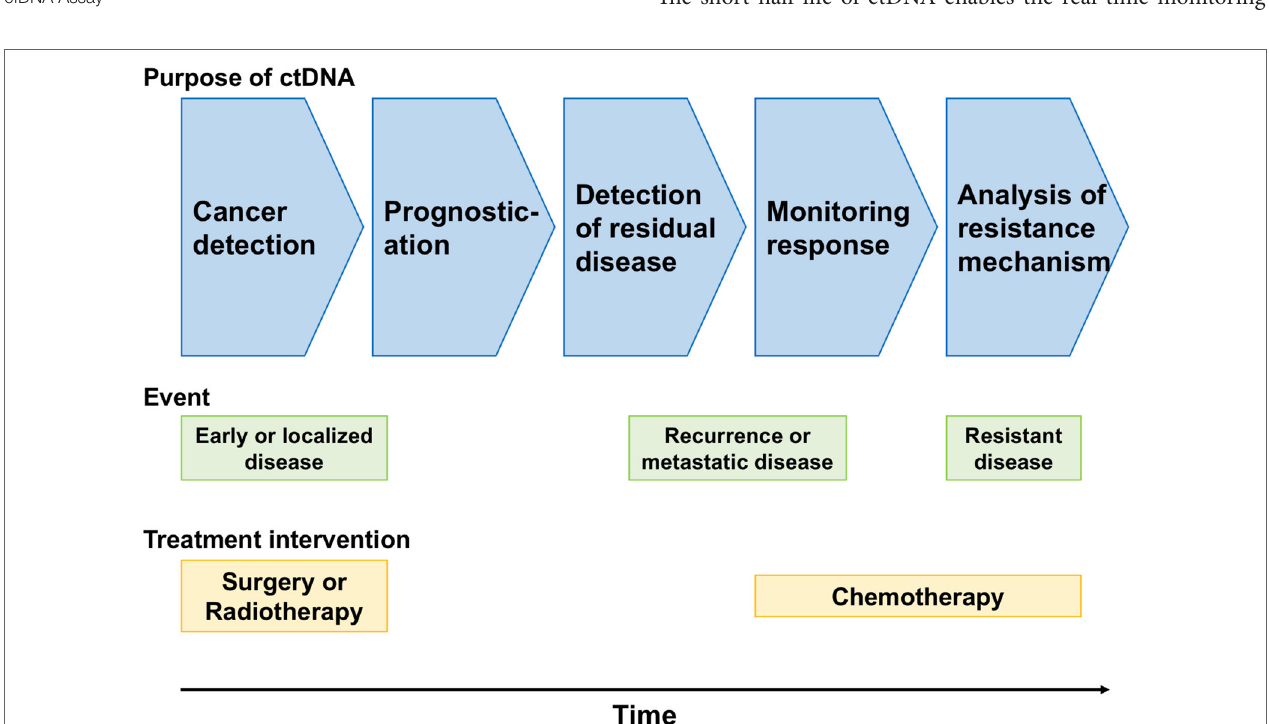
FiGURe 1 | Clinical applications of circulating tumor DNA (ctDNA) in gastrointestinal